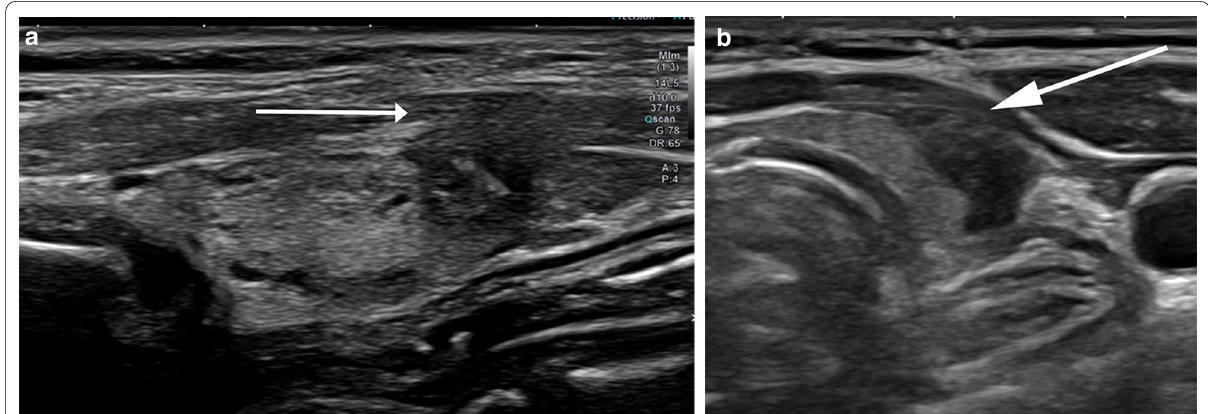
Fig. 8 41-Year-old female patient. a (Sagittal image) and b (transverse image) shows a hypoechoic PTC in left thyroid gland with disruption and loss of perithyroid echogenic line anteriorly (arrow) at site of contact with the tumor suggesting minor ETE. The patient was not offered AS in our study and underwent surgery